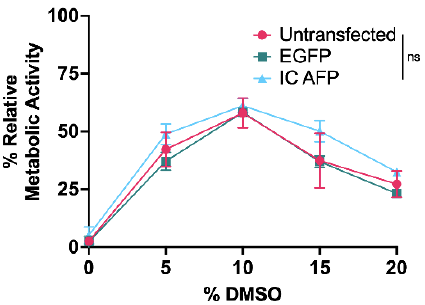
Figure 4. Relative metabolic activity assessed via MTS assay performed on untransfected, EGFP-